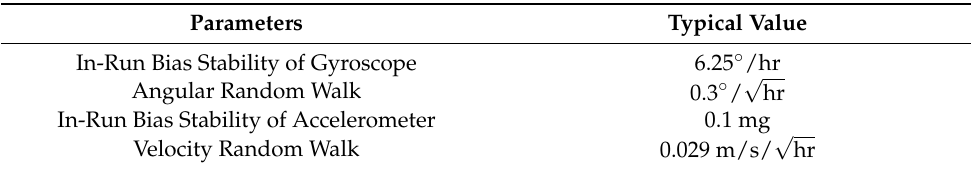
Table 3. Specifications of